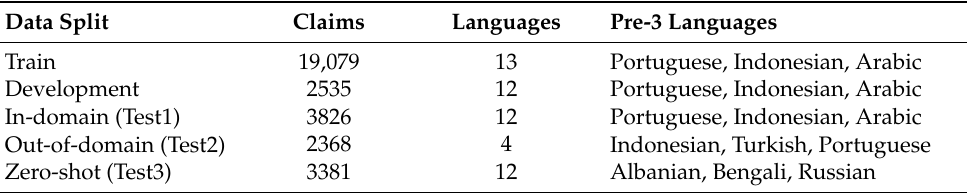
Table 1. X-Fact dataset details. X-FACT contains three challenges sets, namely, in-domain test (Test1), out-of-domain test (Test2), and zero-shot test (Test3). Each set consists of multilingual claims and pieces of evidence, whereby language numbers and pre-three languages are counted. Data Split Claims Languages Pre-3